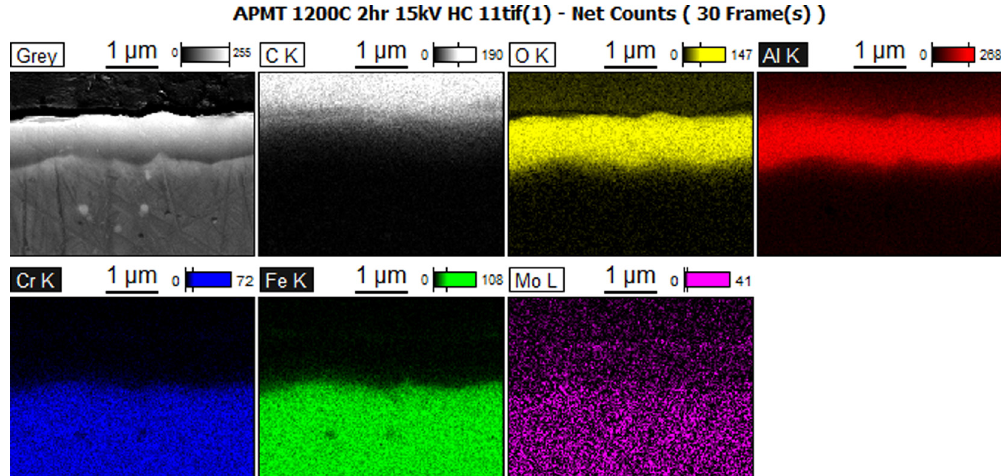
Fig. 4. Coupon of APMT exposed to 100% steam for 2 h at 1200 ° C. A 1 m m-thick alumina layer is observed on it surface.